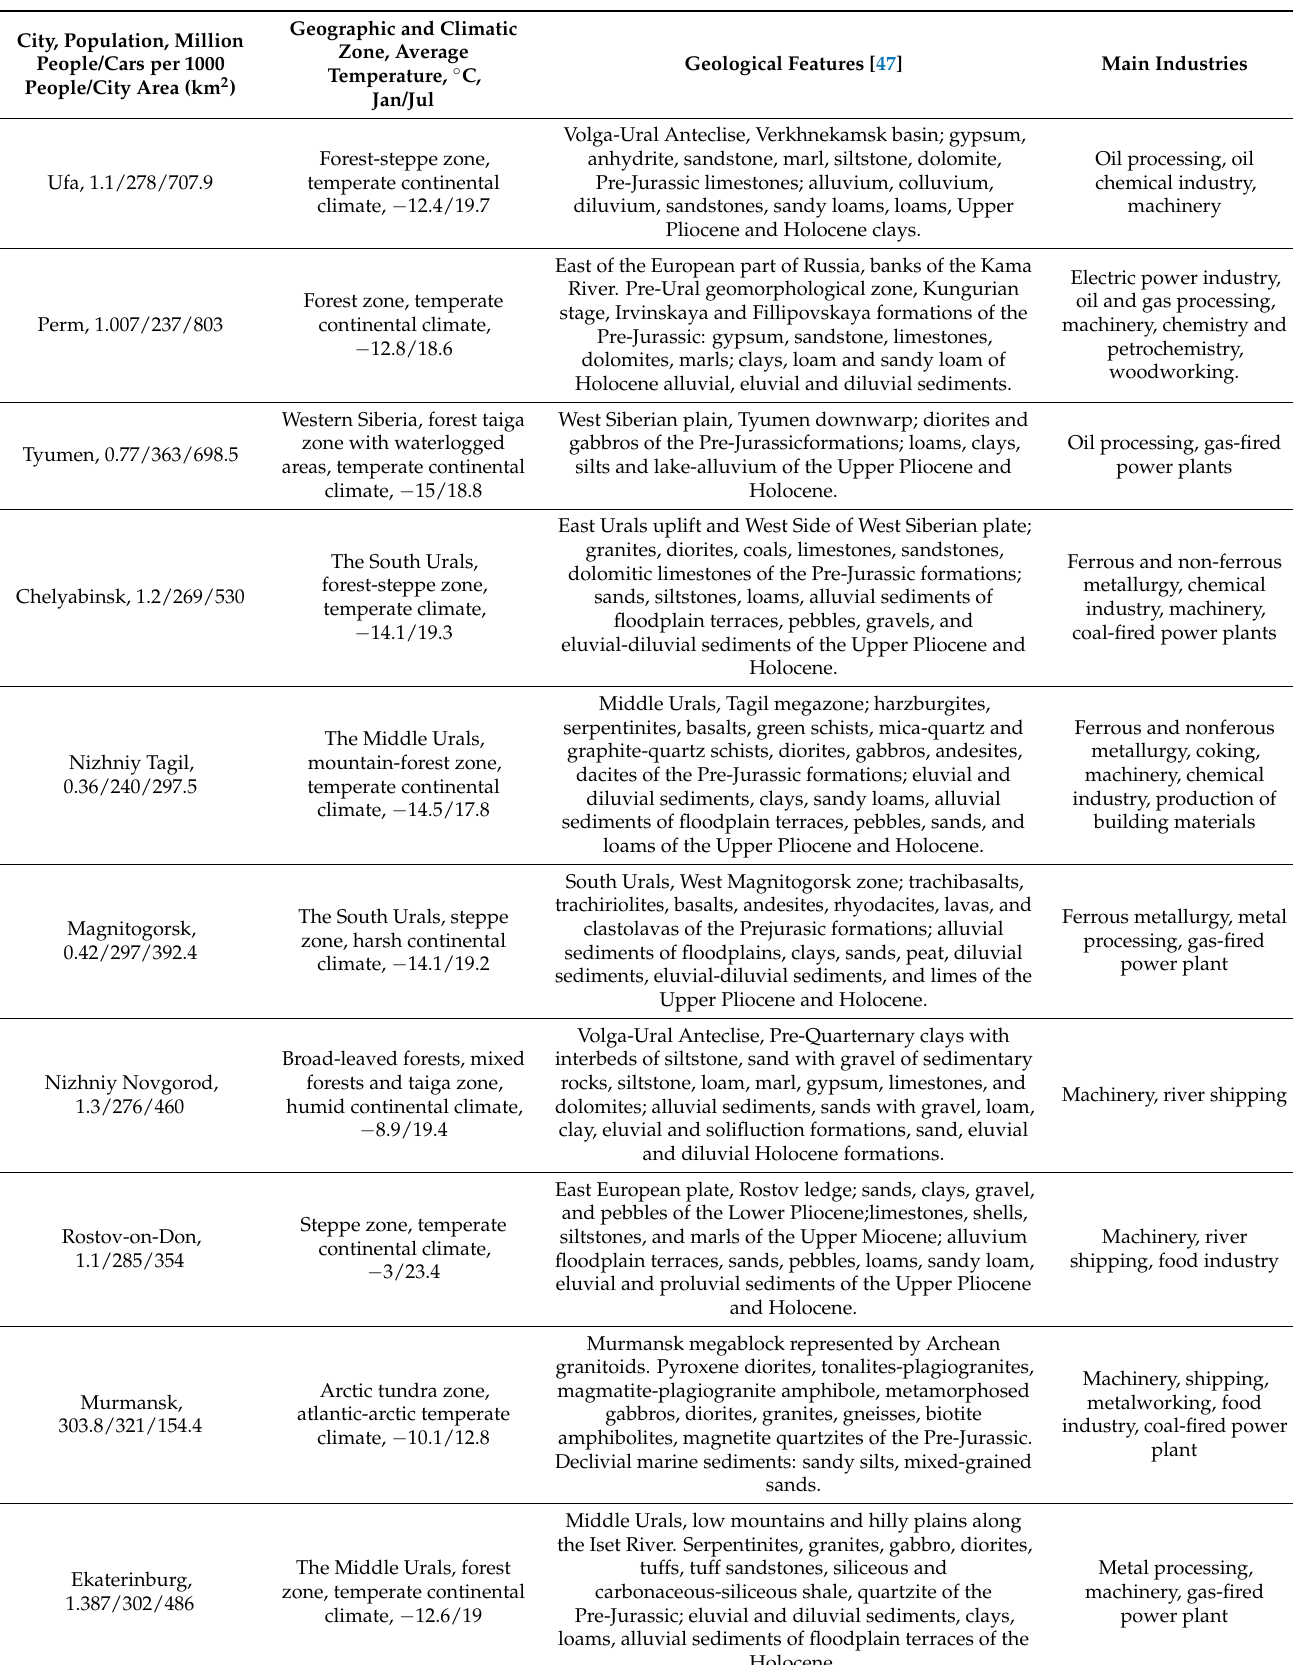
Table 1. The description of the surveyed